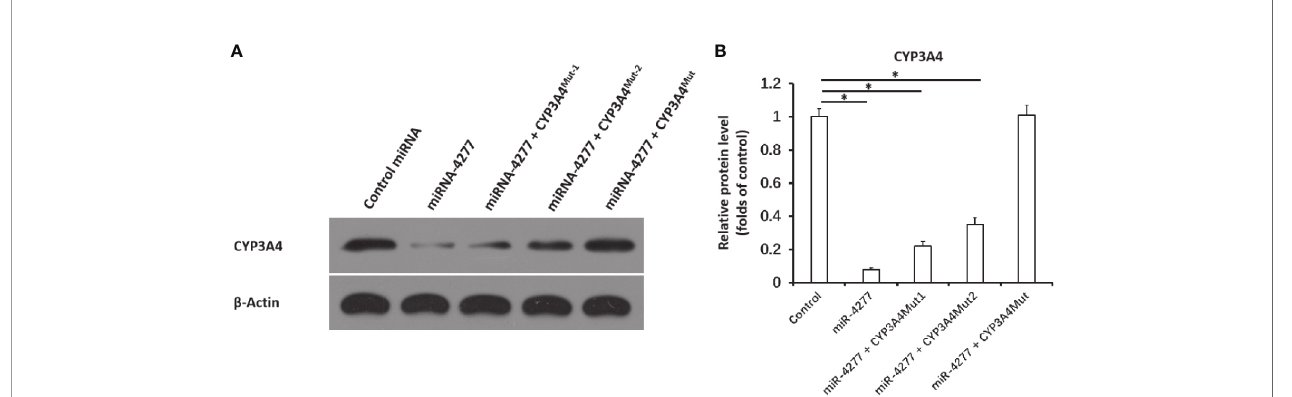
FIGURE 4 | miR-4277 represses the expression of CYP3A4 in MHCC97-H cells. The effect of miR-4277 on wild type CYP3A4 or CYP3A4 mutations (CYP3A4Mut1 [the vector of cyp3a4 with the mutation of the 1 st miR-4277 targeting site], CYP3A4 Mut2 [the vector of cyp3a4 with the mutation of the 2 nd miR-4277 targeting site], or CYP Mut [the vector of cyp3a4 with the mutation of the 1 st and 2 nd miR-4277 targeting site]) in MHCC97-H cells was measured by western blot. The results are shown as blots (A) or the quantitative results (B) . *P <